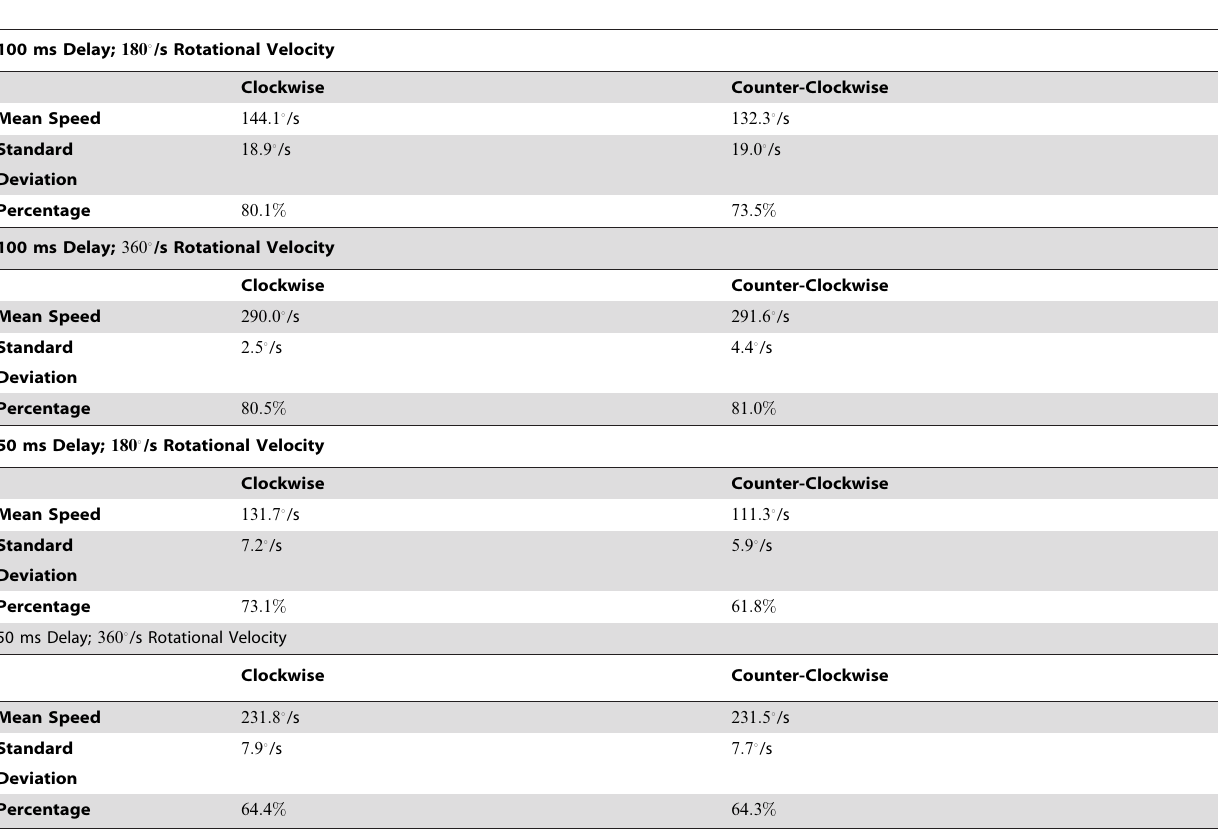
Table 2. Speed of movement of the head direction cell activity packet during testing in the absence of visual